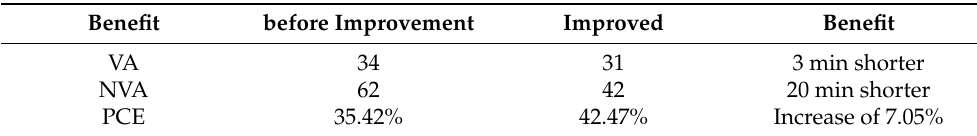
Table 7. Benefit evaluation before and after improving six standard deviations.